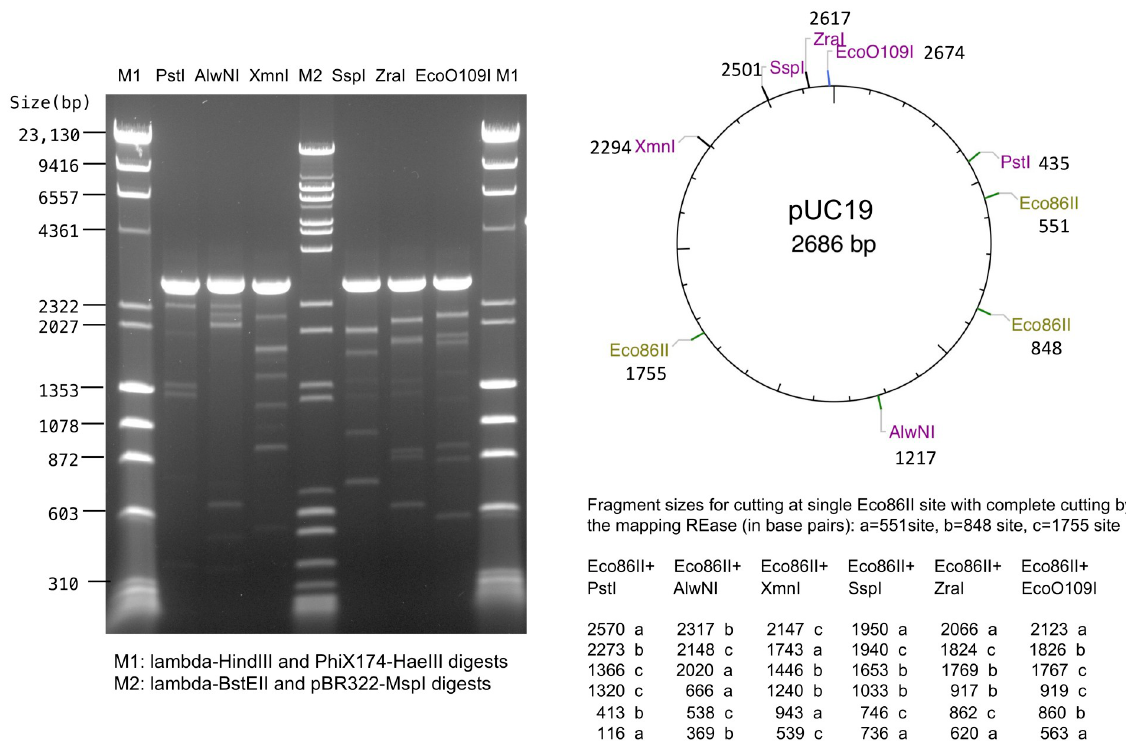
Fig 4. Eco86II endonuclease activity. Partially purified Eco86II enzyme was used to digest pUC19 plasmid substrate containing 3 sites: one in the forward direction and two in reverse orientation. After cutting with Eco86II, the reaction was divided and cut with six REases that cleave pUC19 once at known positions. Although the Eco86II digestion is only partial, fragments having lengths corresponding to the distance between the known REases and the Eco86II cleavage positions are observed, demonstrating specific Eco86II cleavage downstream from its GAGCC recognition motif. The original gel photograph is available as S1 Raw